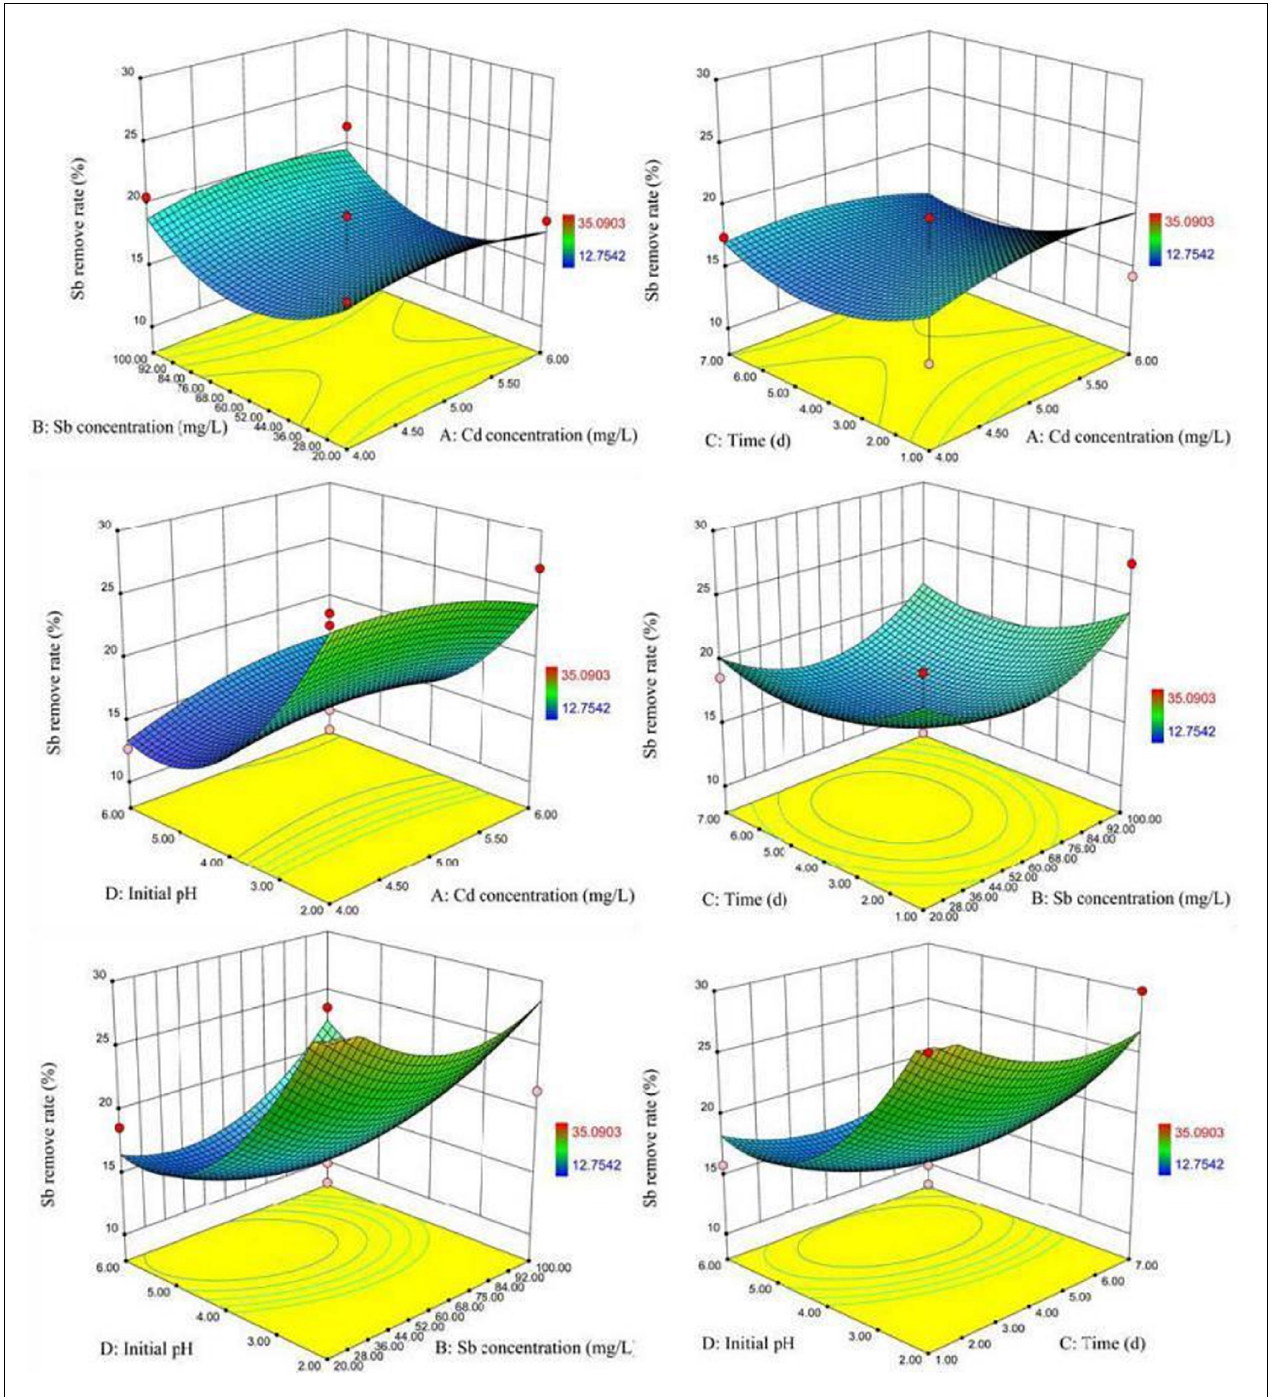
FIGURE 7 | Response surface curves for Sb(III) removal showing the binary